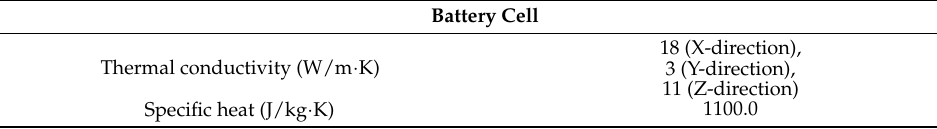
Table 2. Properties of the Battery Cell.